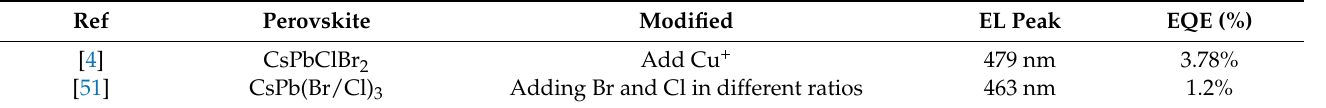
Table 2. Component parameter arrangement in the blue and cyan light